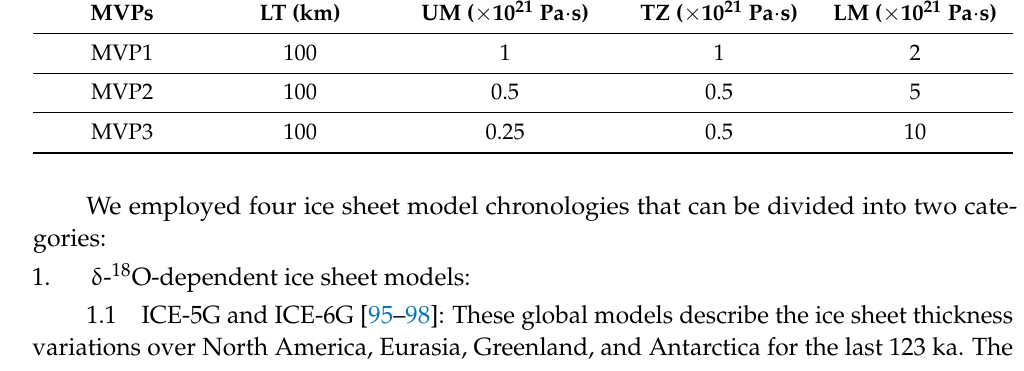
Table 4. Vertical viscosity gradient increasing on the three mantle viscosity profiles (MVPs).